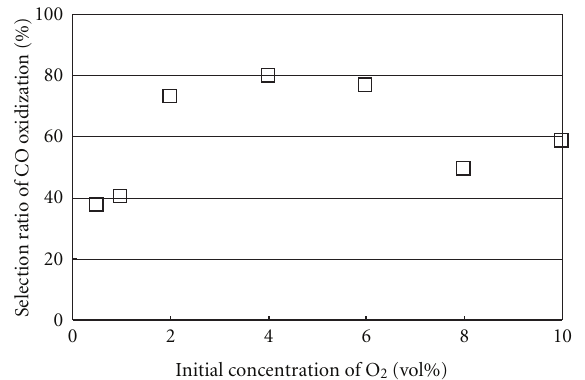
Figure 12: Comparison of selection ratio of CO oxidization among di ff erent initial concentrations of O 2 .